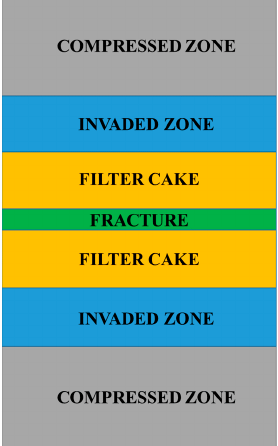
Figure 2. A sketch of the three-zone leak-off model, following [39]. The fluid flow within the compressed formation fluids zone is modeled as the single- phase flow of a slightly compressible fluid in a semi-infinite medium. The fluid velocity, v N , at the interface between the compressed formation fluids zone and the invaded zone can be calculated as follows